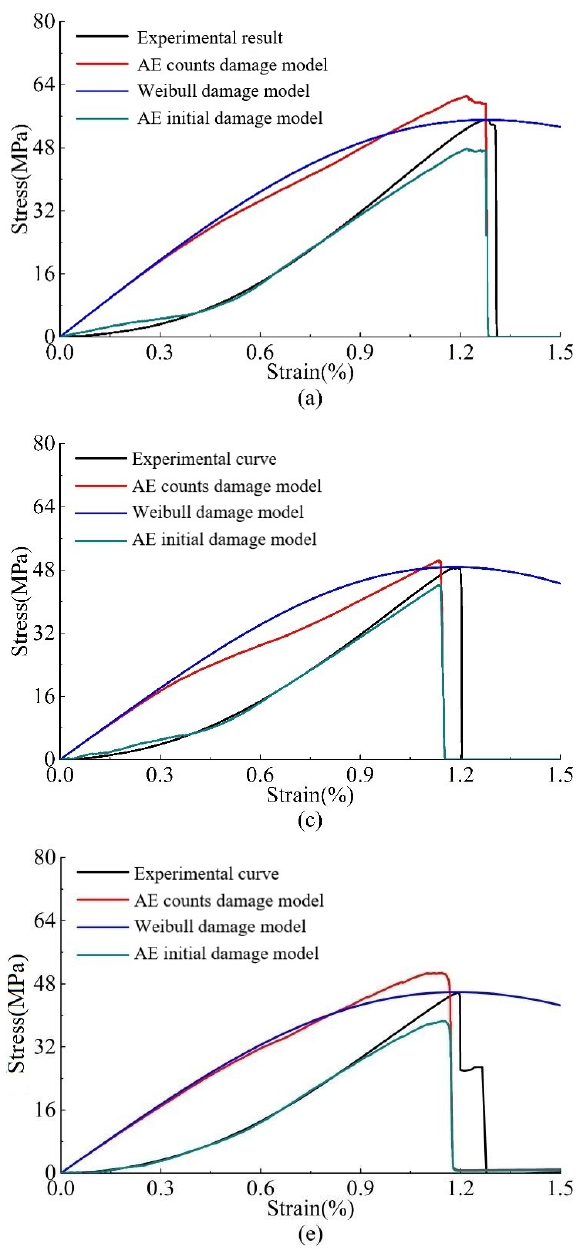
Figure 12. Experimental stress-strain curves of AE damage model, Weibull strength statistical damage model, and AE initial damage model under different loading rates: ( a ) 0.9 kN/s; ( b ) 0.7 kN/s; ( c ) 0.5 kN/s; ( d ) 0.3 kN/s; and ( e ) 0.1 kN/s.